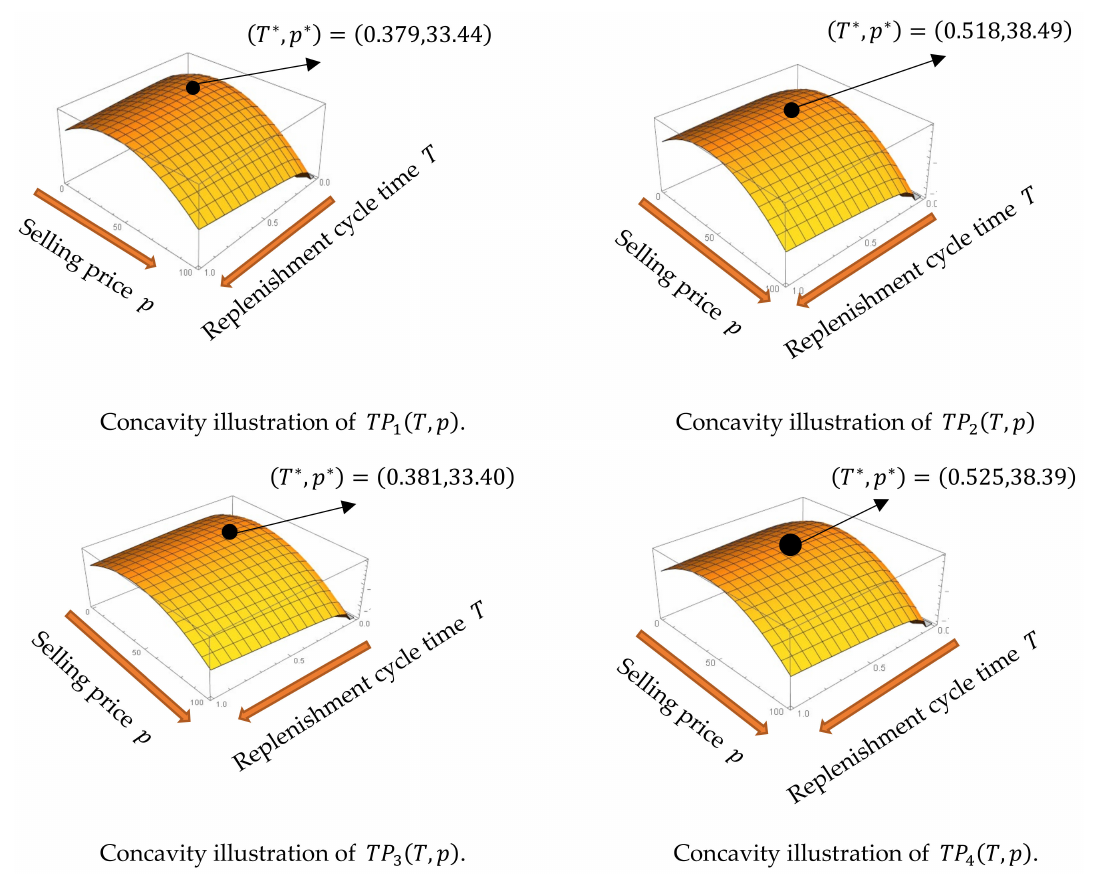
Figure 3. Concavity illustration of different cases. Table 5. Sensitivity analysis concerning the parameters for Cases 1 and